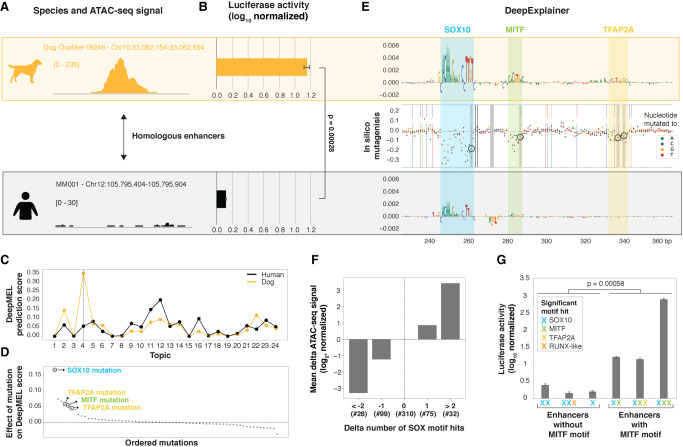
Predicting causal mutations of evolutionary changes in MEL enhancers. (A,B) Example region upstream of APPL2 that is accessible (A) and active (B) in the MEL dog line Dog-OralMel-18249 but not in human MEL lines. (C) DeepMEL prediction score of each of the 24 topics for the dog and human APPL2 enhancer. (D) Effect on topic 4 DeepMEL score on the dog sequence when in silico simulating each of the single detected point mutations between the dog and human APPL2 enhancer. (E) DeepExplainer plots of the middle 120 bp of the dog and human APPL2 enhancer. In the middle, the effect of each possible point mutation between the dog and human sequence on the MEL DeepMEL score was in silico calculated and is represented by colored dots depending on the nucleotide to which the original dog nucleotide was in silico mutated. Truly existing point mutations between the dog and human sequence are highlighted by color-coded vertical dashed lines. Four mutations that decrease the motif score of the SOX10, MITF, and TFAP2A motifs are highlighted by a gray box and are encircled. (F) Bar plot showing the mean effect on the log2 delta ATAC-seq signal of a non-human region compared to the human homolog depending on the number of SOX10 motif hits lost or gained. Only regions having no change in the number of significant TFAP2A, MITF, and RUNX motifs hits were used. The y-axis is normalized to the category with no changes in the number of significant SOX10 motif hits. The number of regions in each of the categories is mentioned (#). (G) Luciferase assay on six human or dog enhancers. Significant motif hits per enhancer are shown with colored crosses. For the luciferase assays: luciferase activity in MM001 is shown relative to Renilla signal and is log10 transformed. P-values were determined using Student's t-test, and the error bars represent the standard deviation over three biological replicates.